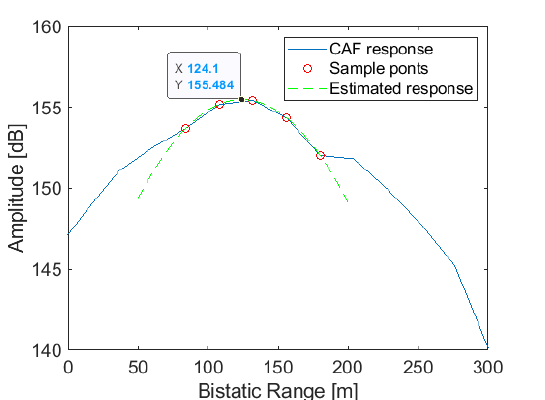
Figure 5. Target’s range estimation by means of 5 points around the maximum. The real target range is 125 m, while the maximum of the CAF is obtained at 132 m. The estimated range with this approach is 124.1